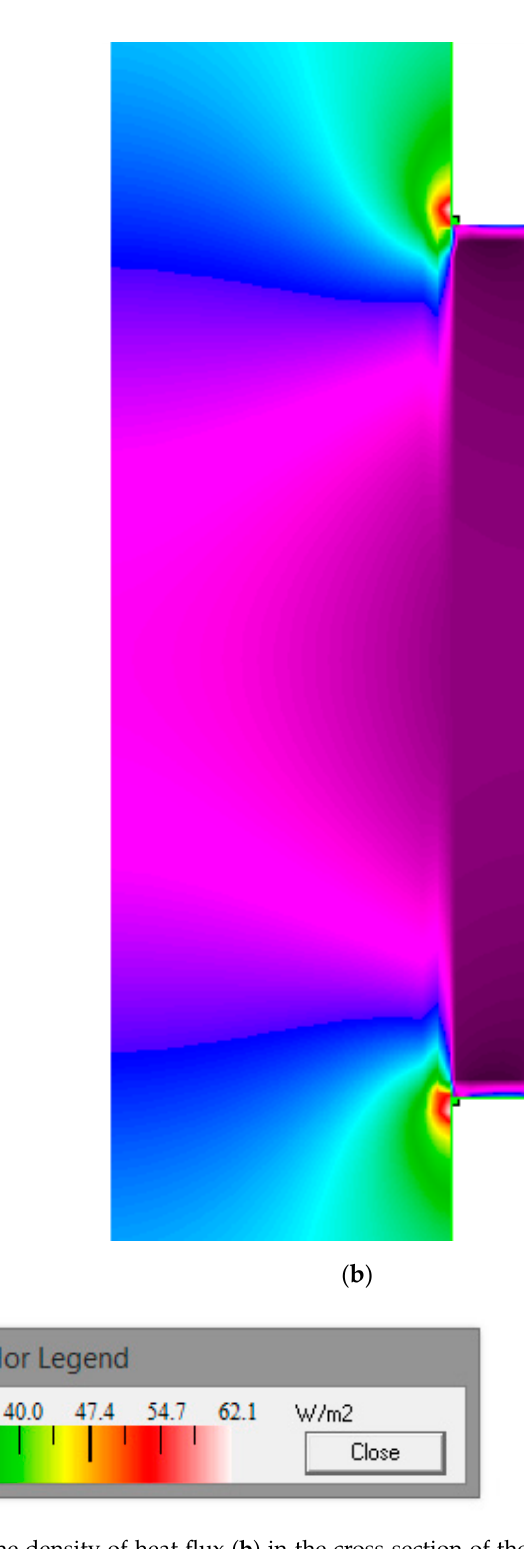
Figure 15. Distribution of isotherms ( a ) and the density of heat flux ( b ) in the cross-section of the envelope (only a fragment is presented in the picture) obtained from numerical